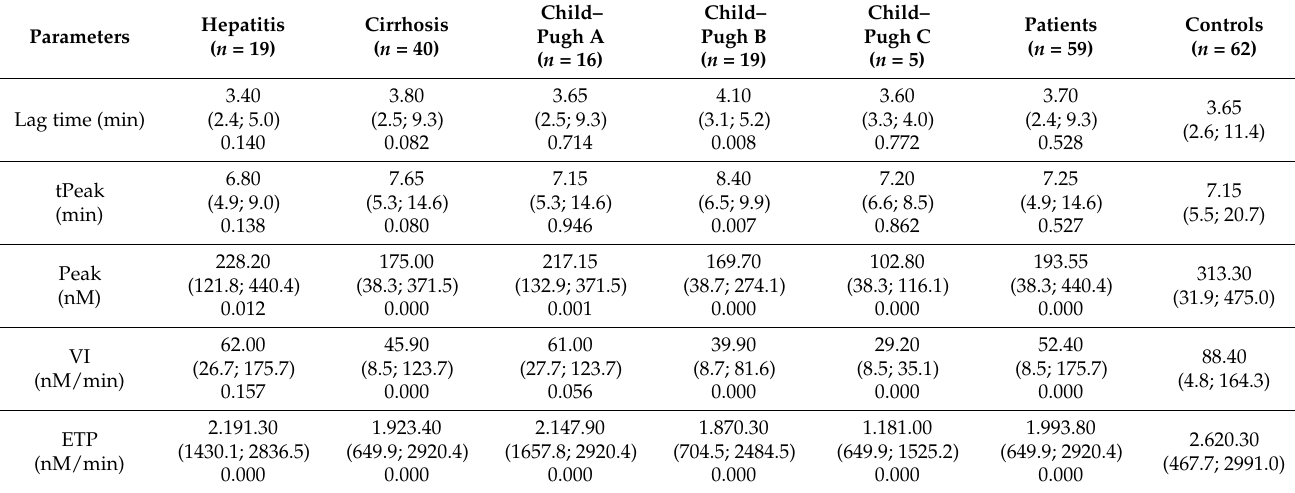
Table 3. The mean values of thrombin generation parameters (controls and patients with chronic hepatitis).